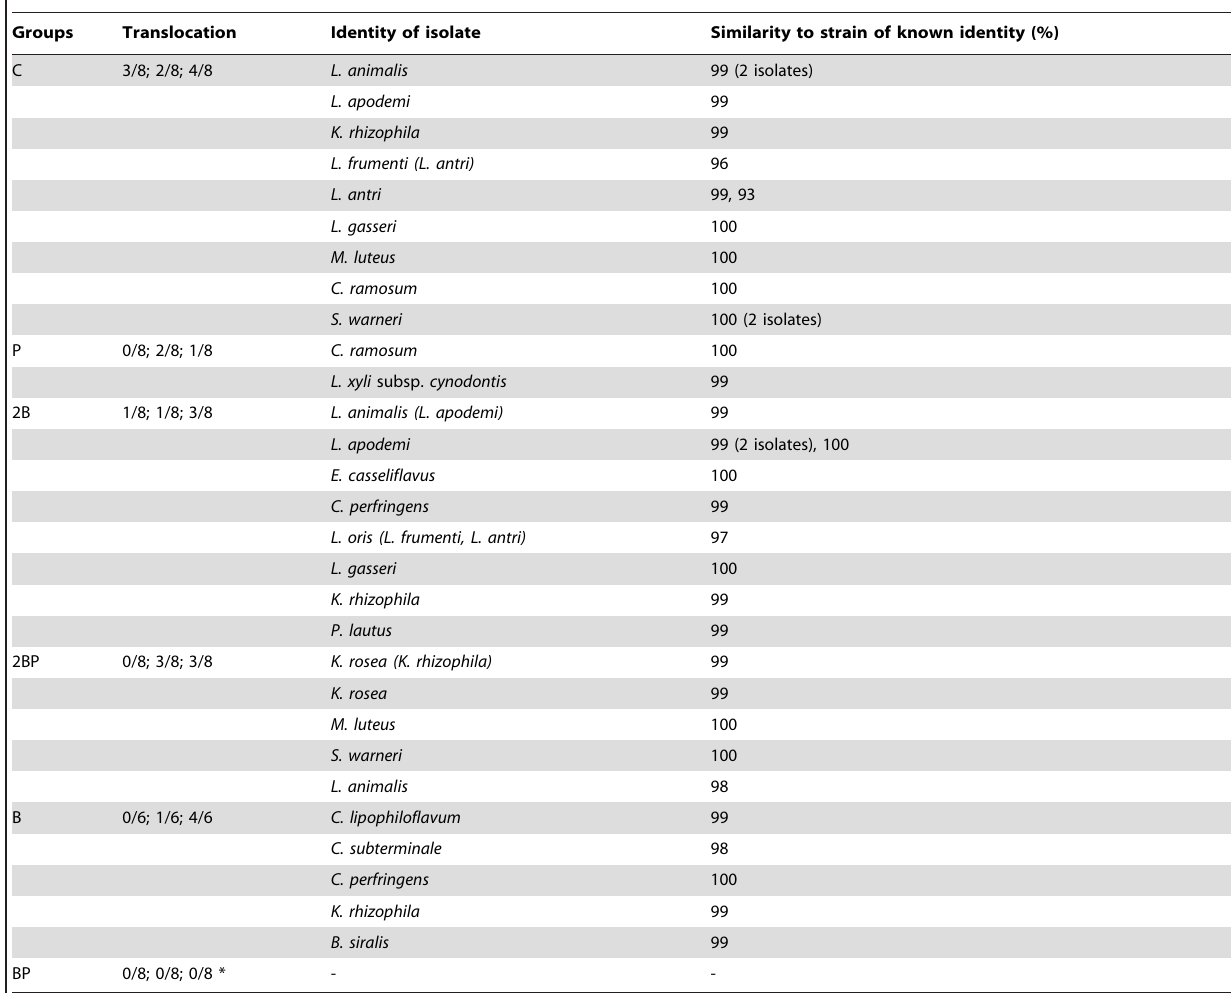
Table 4. Incidence of translocations and identified isolates from the livers.